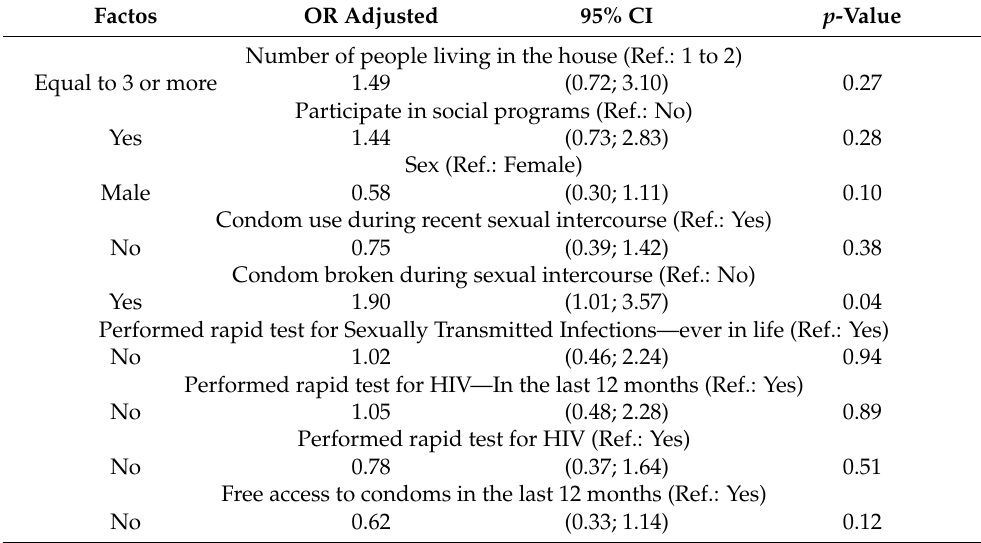
Table 4. Results of the multiple logistic regression analysis between factors and C. trachomatis among riverine, in the Brazilian Amazon,